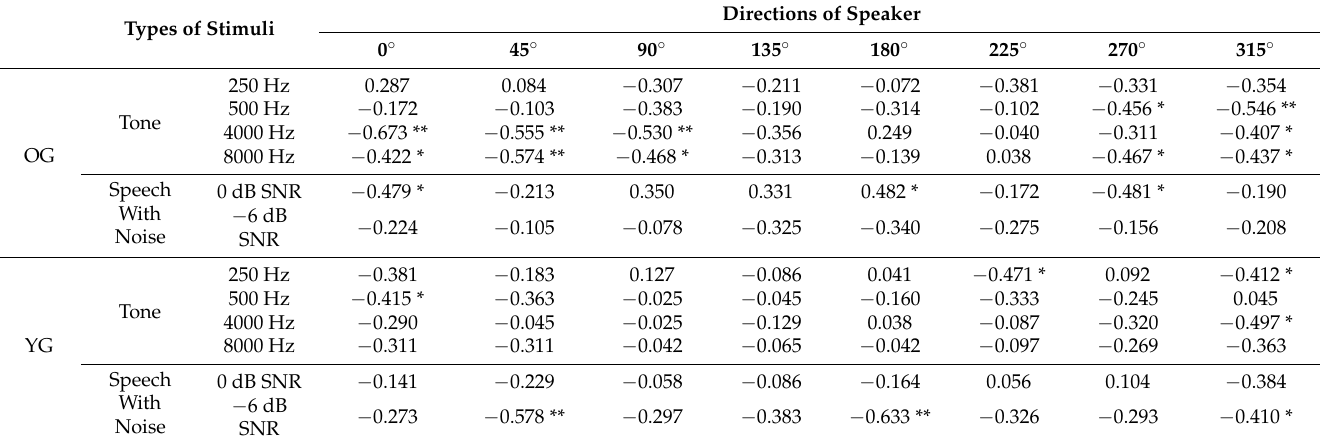
Table 3. Results of the Pearson correlation between listening effort and external variables for the two groups. Types of